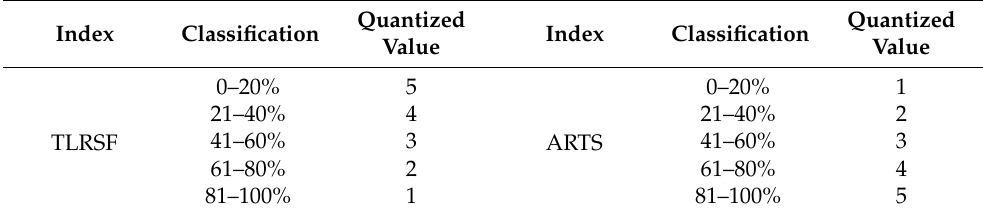
Table 2. Indices system of underground coal fire risk assessment for Xinjiang